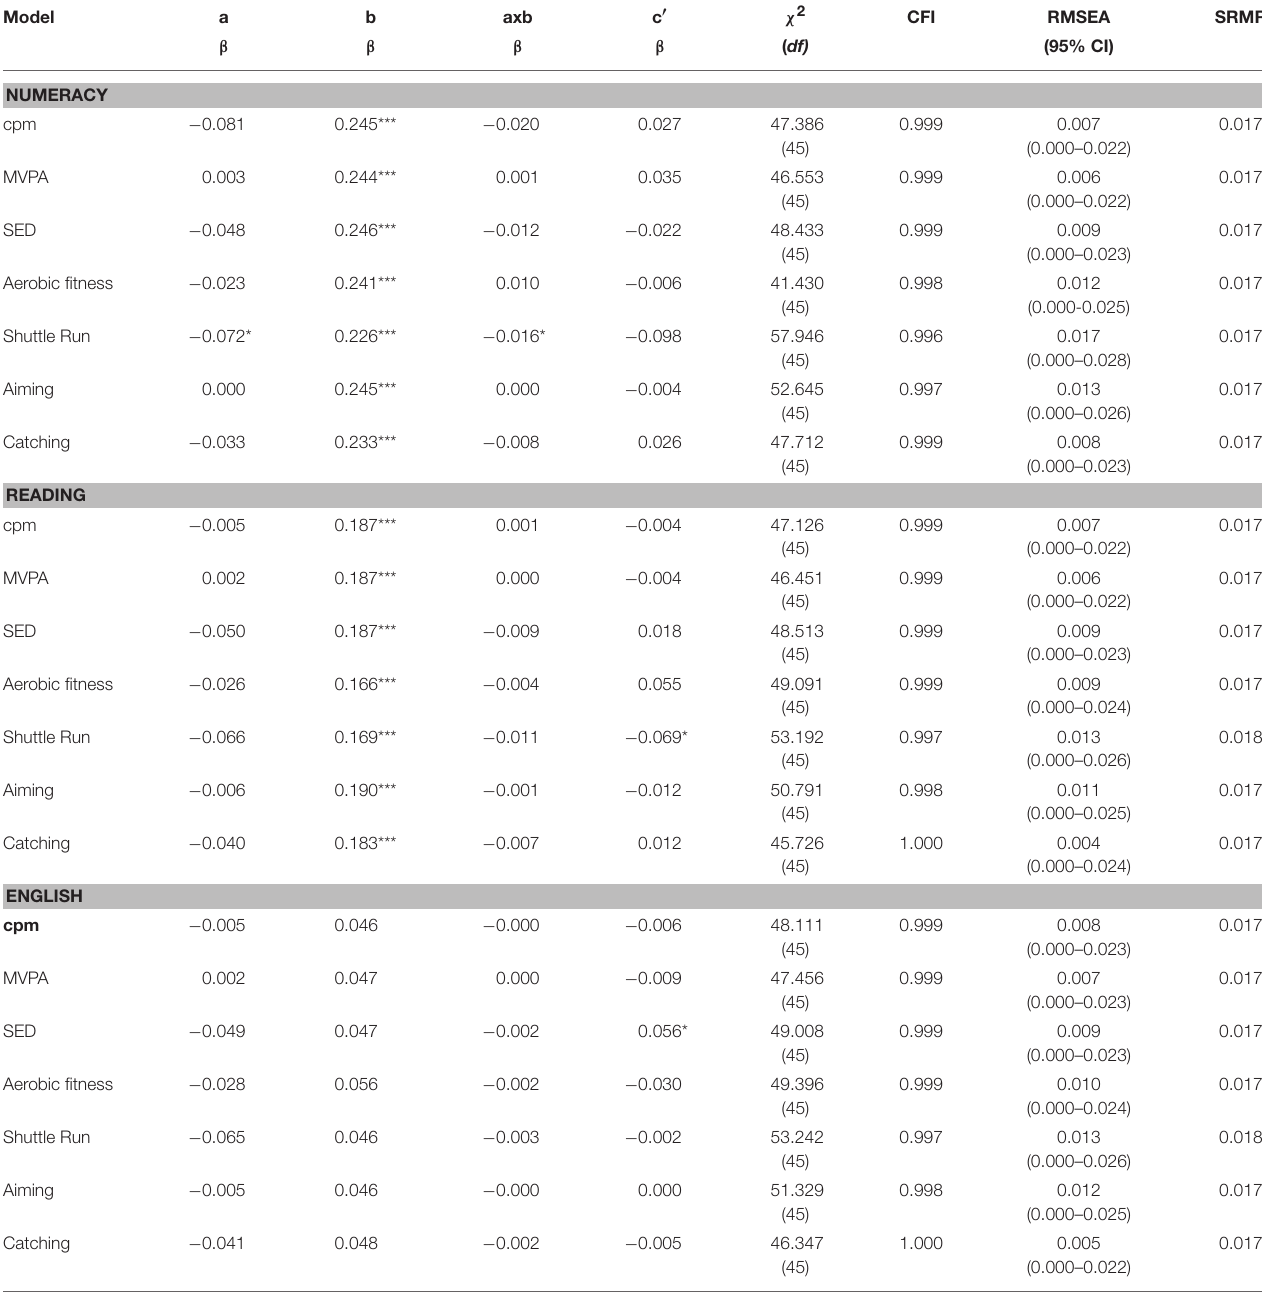
TABLE 3 | Standardized coefficients for the paths and goodness of fit indices for the half-longitudinal mediation models controlled for covariates.